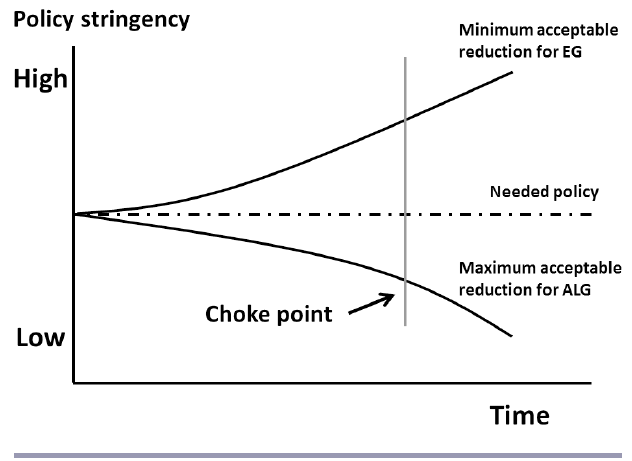
Fig. 6. Polarization of interest group demands. ALG = agricultural lobby group; EG = environmental